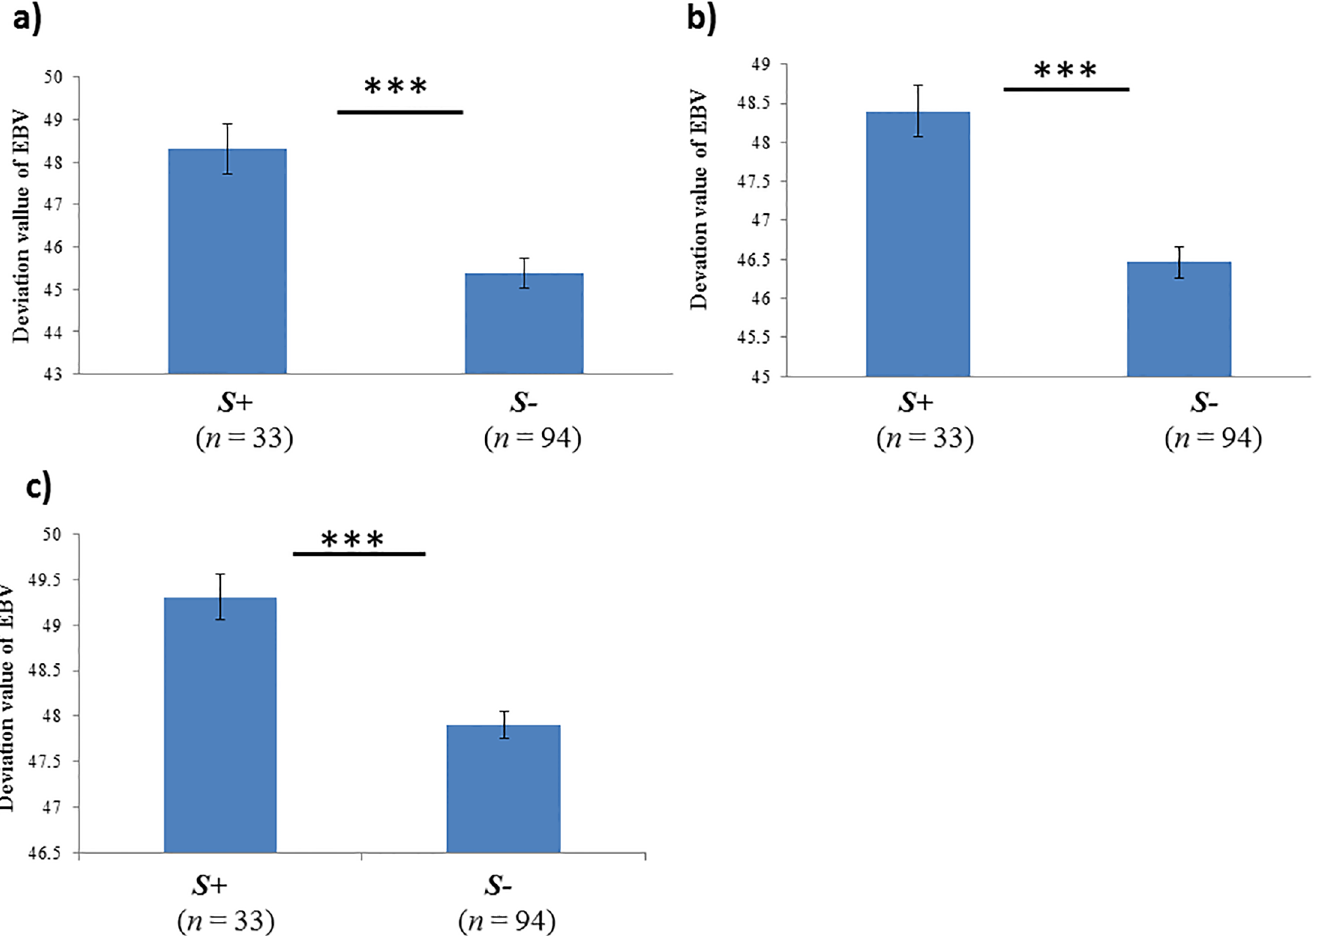
Fig 1. LDHA genotypes (existence of allele S ) and deviations of estimated breeding value (DEBV) under different race traits. a) Race 3, b) Race 4, and c) Race 5.